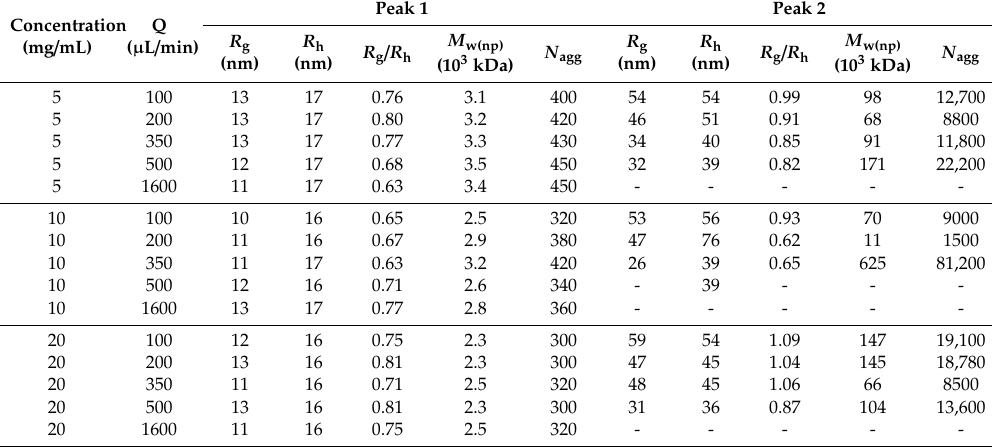
Table 3. Characteristics of polymer D (mPEG 5K - b -p(HPMA-Bz) 2.7K ) nanoparticles as determined by